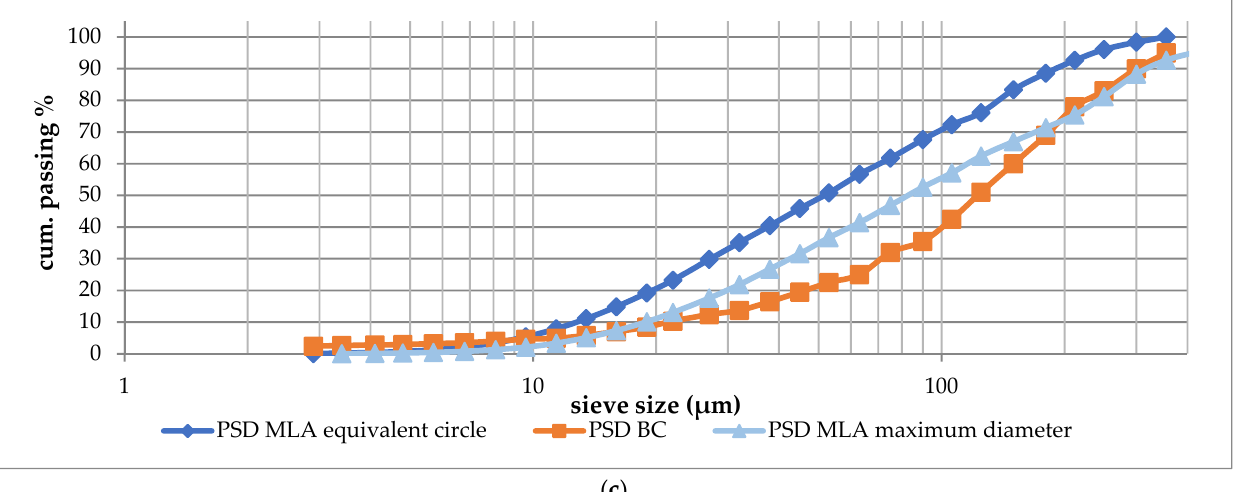
Figure 5. Particle size distribution curves (PSD) as measured by laser diffractometry (PSD BC) and calculated from MLA data (PSD MLA). ( a ) Leipzig, ( b ) Dresden, ( c ) Chemnitz.